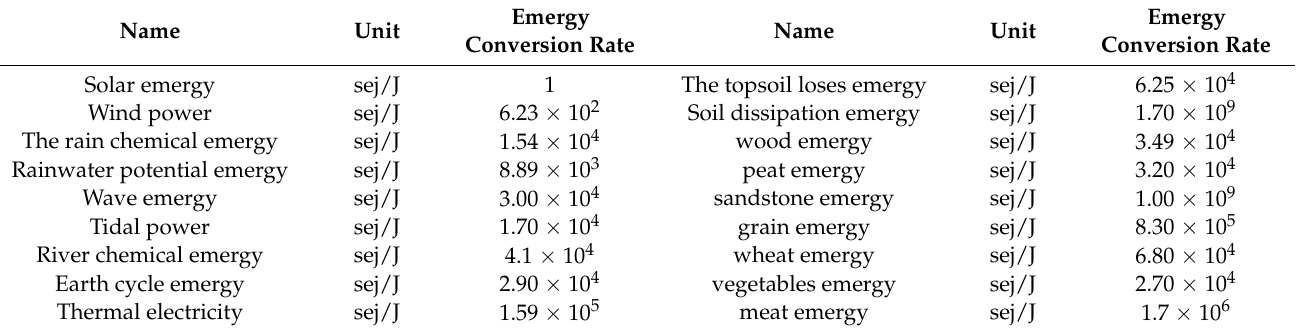
Table 1. Solar emergy conversion rate of the main emergy substance